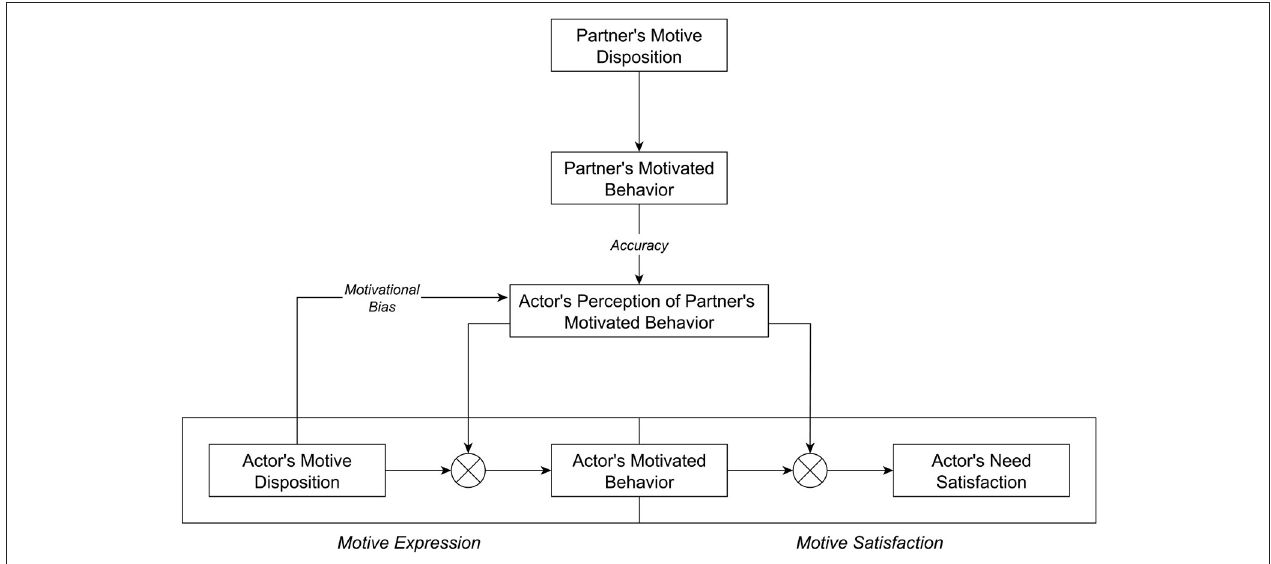
FIGURE 1 | The motivational interdependence in couples model. Figure available at: https://osf.io/2fz5w/ under a CC-BY4.0